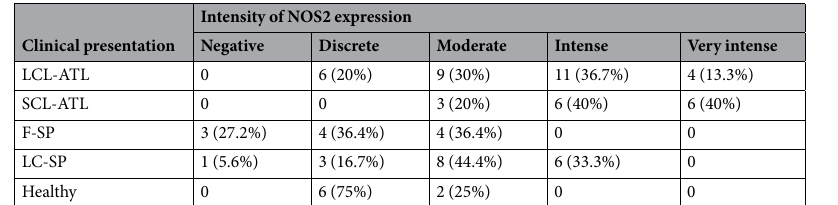
Table 3. Intensity of NOS2 expression in American tegumentary leishmaniasis and sporotrichosis lesions. Data shown as number of cases. LCL-ATL: localized cutaneous leishmaniasis; SCL-ATL: sporotrichoid